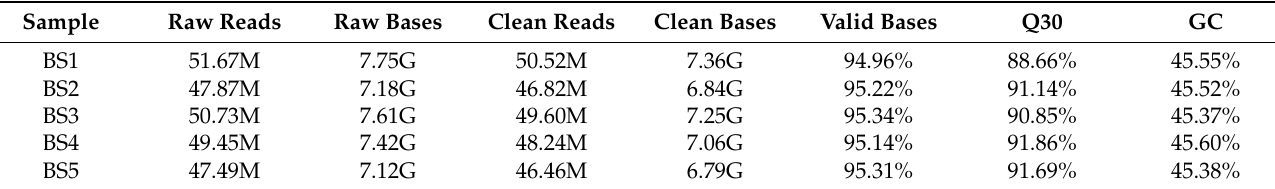
Figure 2. Flower phenotypes at different developmental stages. ( a ) BS1: vegetative bud, correspond- ing to Figure 1a. ( b ) BS2: flower bud, corresponding to Figure 1d. ( c ) BS3: formation of inflorescence, corresponding to Figure 1f. ( d ) BS4: initial flowering stage, corresponding to Figure 1k. ( e ) BS5: full blooming stage, corresponding to Figure 1l. Table 1. Quality statistics of sample sequencing data.